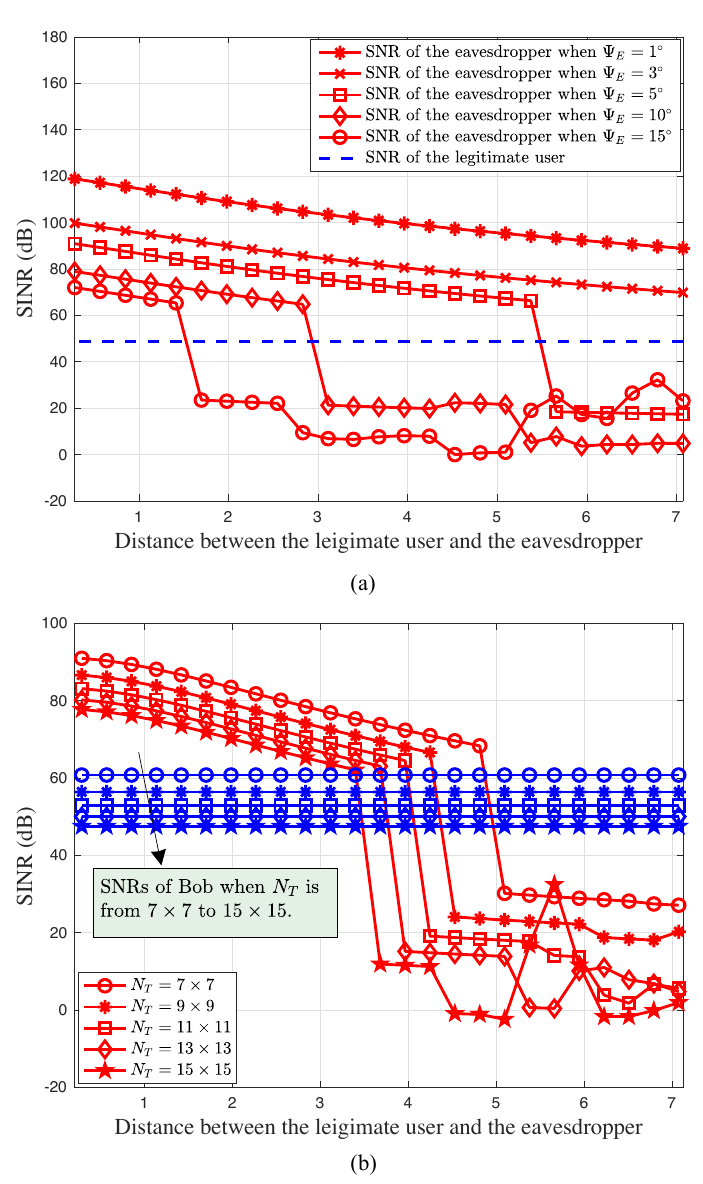
Figure 4. SINR according to distance between legitimate user and eavesdropper, who are located at center of room and ( d E , d E ) , respectively. N T LED transmitters are assumed to be uniformly distributed on a square lattice in room of 20 × 20 m 2 . FoV of eavesdropper is denoted by Ψ E . N T = 10 × 10 is used for ( a ), and Ψ E = 10 ◦ is used for ( b